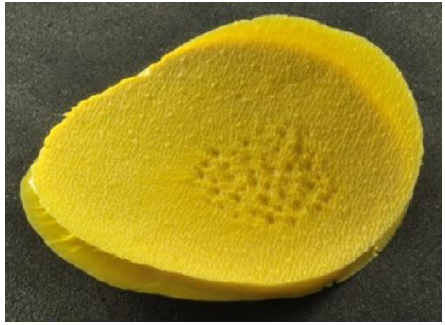
Figure 2. Silicone imprint of a goose bump area (approximately 5 cm diameter)